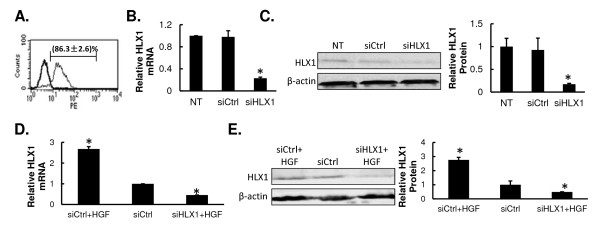
Targeting HLX1 with siRNA abrogates its basal expression and induction by HGF. (A) DY-547-labeled control siRNA (siCtrl) was transfected into HTR-8/SVneo cells for 24 h. The transfection efficiency, as determined by flow cytometry, is presented. Black line, non-transfected (NT) cells; gray line, siCtrl cells. (B) The steady-state mRNA level of HLX1 in indicated HTR-8/SVneo cells was examined by qPCR and calculated as the ratio of HLX1 to ß-actin. (C) The protein level of HLX1 in indicated HTR-8/SVneo cells was examined by Western immunoblot. A representative gel image is presented on the left and quantifications of HLX1 to Î²-actin signal ratio on the right.(D) HTR-8/SVneo cells were transfected with either siCtrl or siHLX1 and treated with or without 20 ng/mL HGF. The steady-state mRNA level of HLX1 was examined by qPCR and calculated as the ratio of HLX1 to Β-actin. (E) HTR-8/SVneo cells were treated as in (D) and the protein level of HLX1 was examined by Western immunoblot. A representative gel image is presented on the left and quantifications of HLX1 to Î²-actin signal ratio on the right. Quantitative data are presented as mean Â± SD for three independent experiments. For (B) and (C), the relative ratio in NT cells arbitrarily defined as 1. *P < 0.01, vs. NT and siCtrl cells. For (D) and (E), the relative ratio in siCtrl-transfected cells arbitrarily defined as 1. *P < 0.01, vs. siCtrl cells.